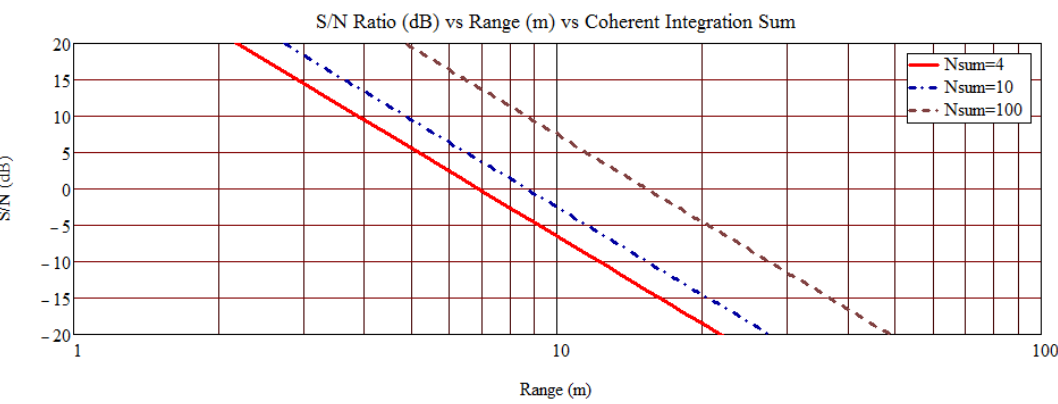
Figure 7. Predicted signal-to-noise (S/N) ratio as a function of range and number of synchronous integrations (Nsum) for a 915 MHz OFC SAW system. The acceptable S/N for temperature extraction is between 3 and 10 dB. Predictions yield a range of approximately 5 meters, which is consistent with current open range